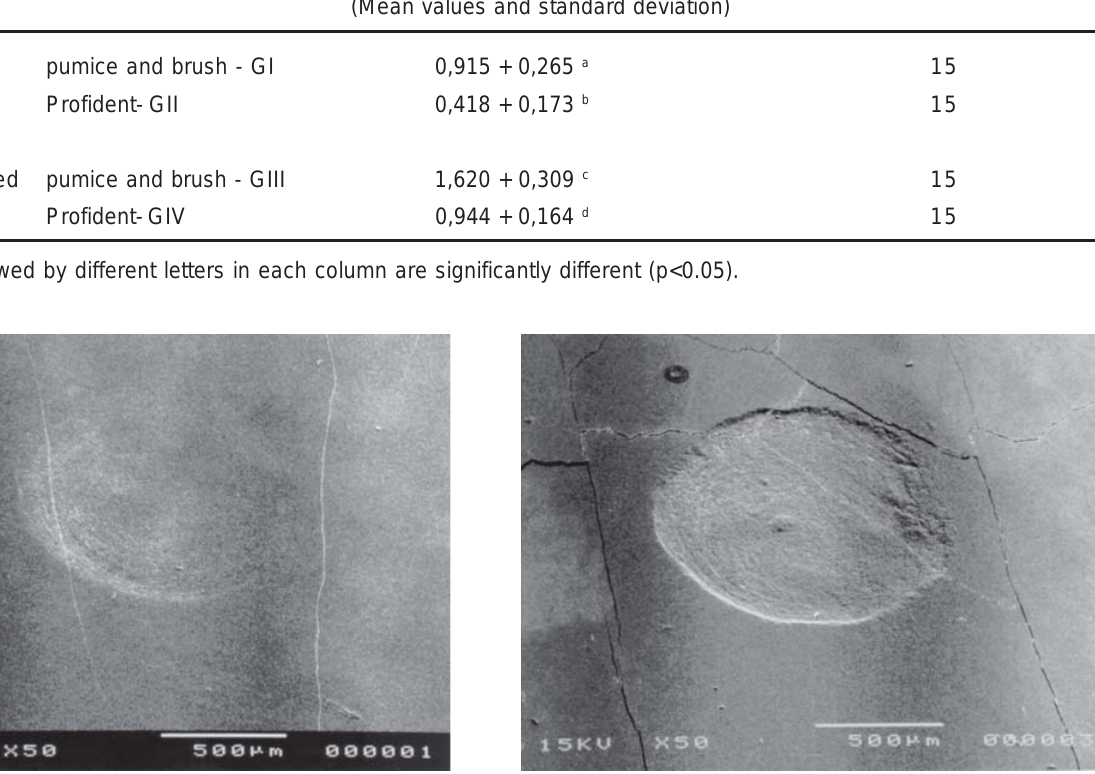
FIGURE 3- Scanning electron microscopy of sound enamel after prophylaxis with pumice slurry- Group I (Original